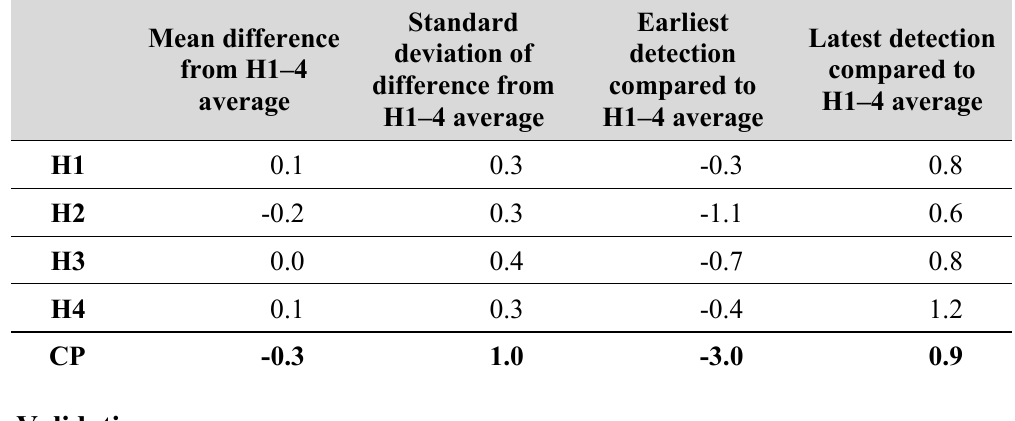
Table 1 Performance of the individual observers and the computer algorithm, compared to the human observers ’ average (calibration, Danish and Dutch sites, all values in